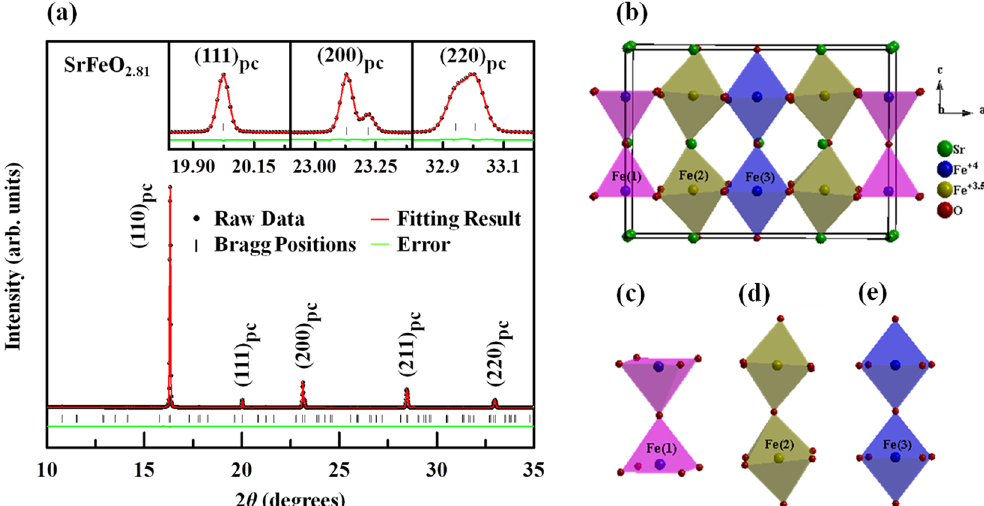
Figure 1. ( a ) Observed (red dots), calculated (black line) and difference (bottom green line) patterns of SrFeO 2.81 , obtained using Lebail refinement of synchrotron X-ray powder diffraction data. Vertical check marks above difference profiles indicate Bragg reflections. Insets magnify selected pseudocubic reflections, ( b ) crystalline structure of SrFeO 2.81 ; valence Fe 4 + is attributed to Fe(1), Fe(3) and Fe 3.5 + is attributed to Fe(2), based on previous work 1 , ( c ) FeO 5 square pyramidal, ( d ) FeO 6 distorted octahedra, and ( e ) FeO 6